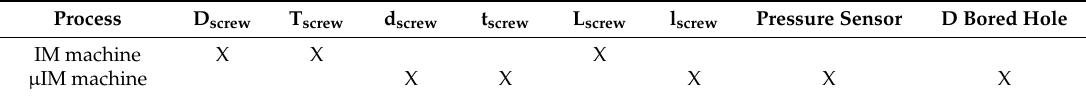
Table 4. Feature blocks of the metering phase for the two